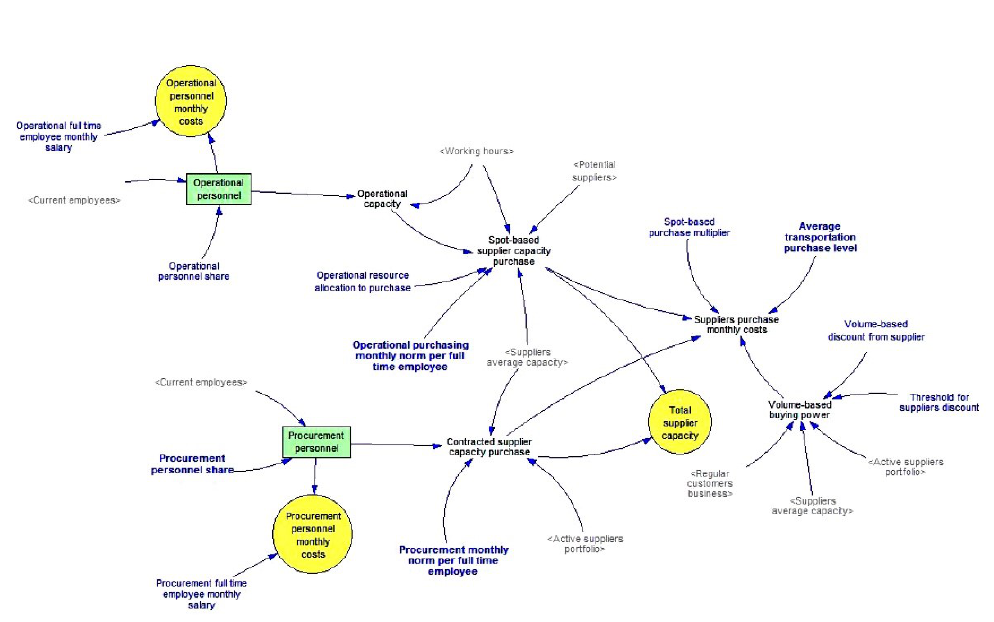
Fig. 4. 3PL procurement process (developed by the